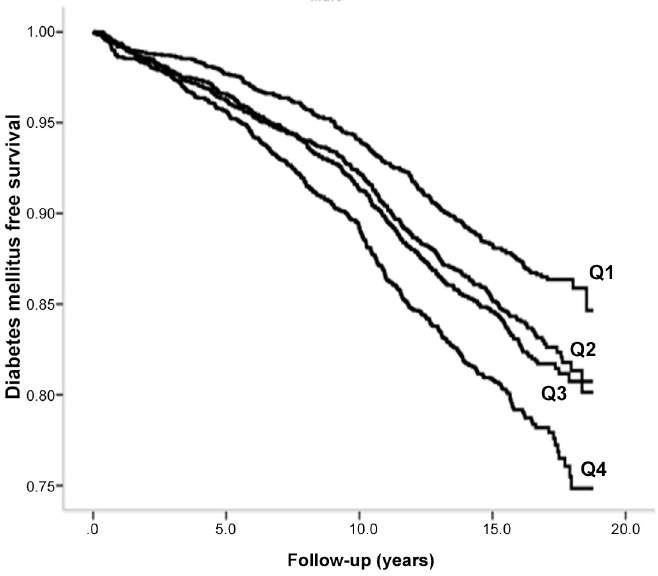
Fig 2. Diabetes mellitus free survival in relation to quartiles of total leukocytes in